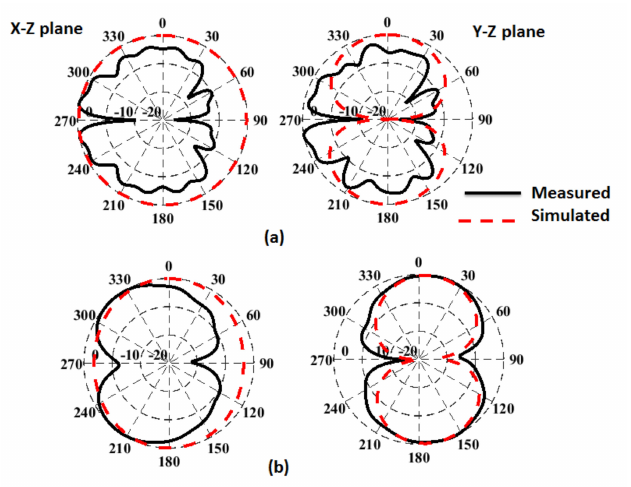
Figure 5. Normalized radiation pattern results of the CPW dual − band monopole antenna ( a ) at 2.45 GHz and ( b ) at 4.8 GHz.